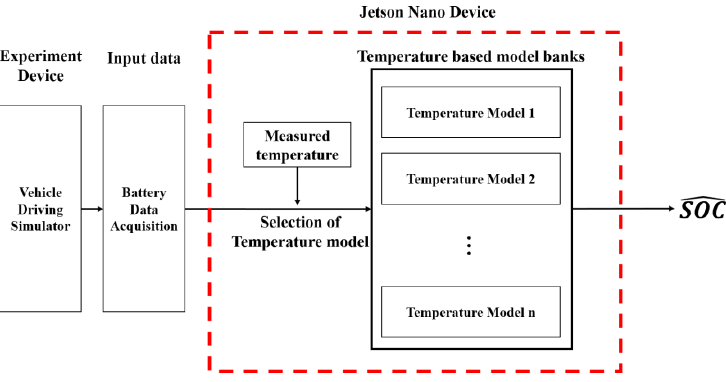
Figure 3. Proposed SOC-estimation method.